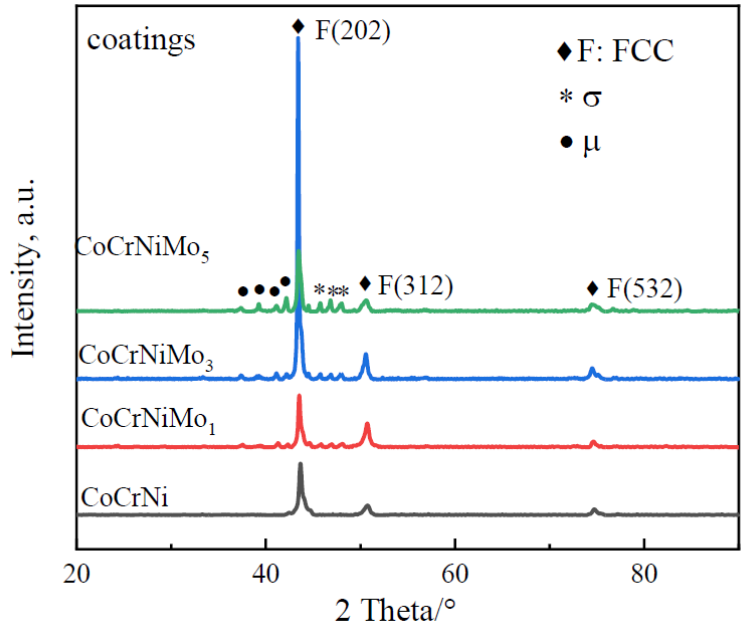
Figure 3. XRD spectras of CoCrNiMo x coating after laser